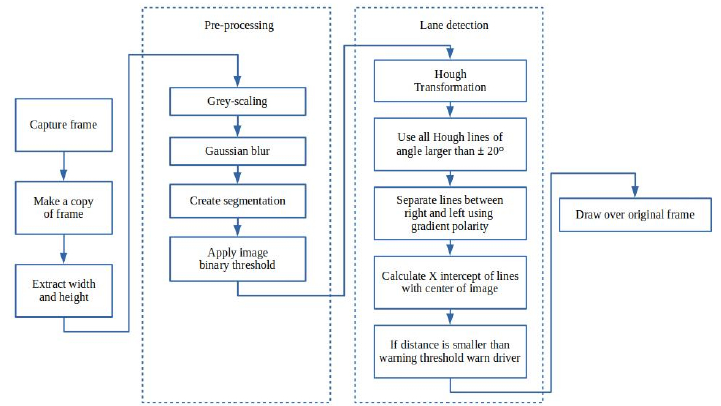
Figure 13. Functional diagram of the designed lane detection for lane